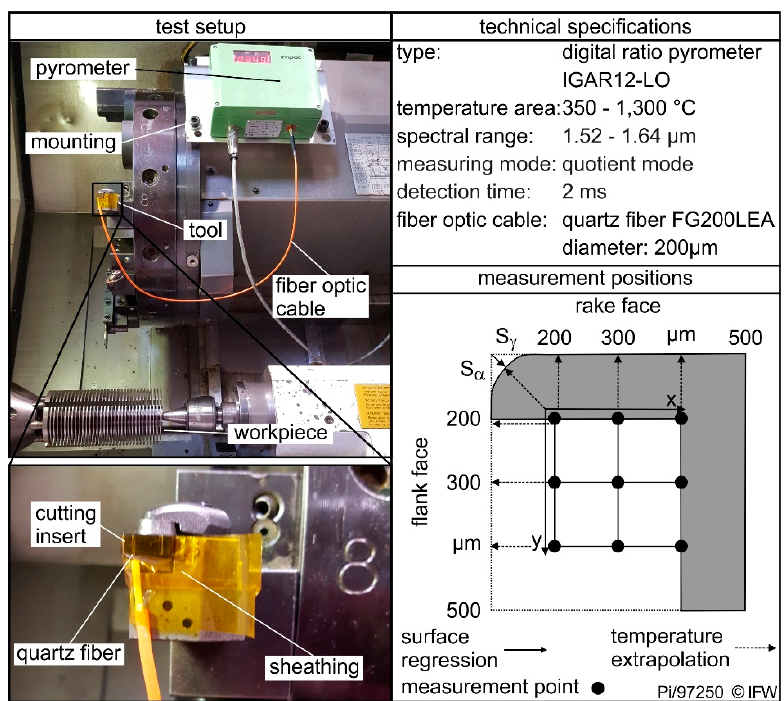
Figure 1. Experimental test setup and technical specifications for the temperature measurements. Table 3. Used cutting edge microgeometries (calculation of l α and l γ according to The quartz fiber was positioned by means of previously set grooves in the tool. The grooves were produced by laser ablation on a Sauer Lasertec 40S (Sauer, Pfronten, Germany). The depth, as well as the distance to the rake face, were varied in order to position the fiber accordingly. The measuring points were arranged in a rectangular pattern with an edge length of 0.2 mm. The measurement closest to the cutting edge was performed at a distance of 0.2 mm from the flank and